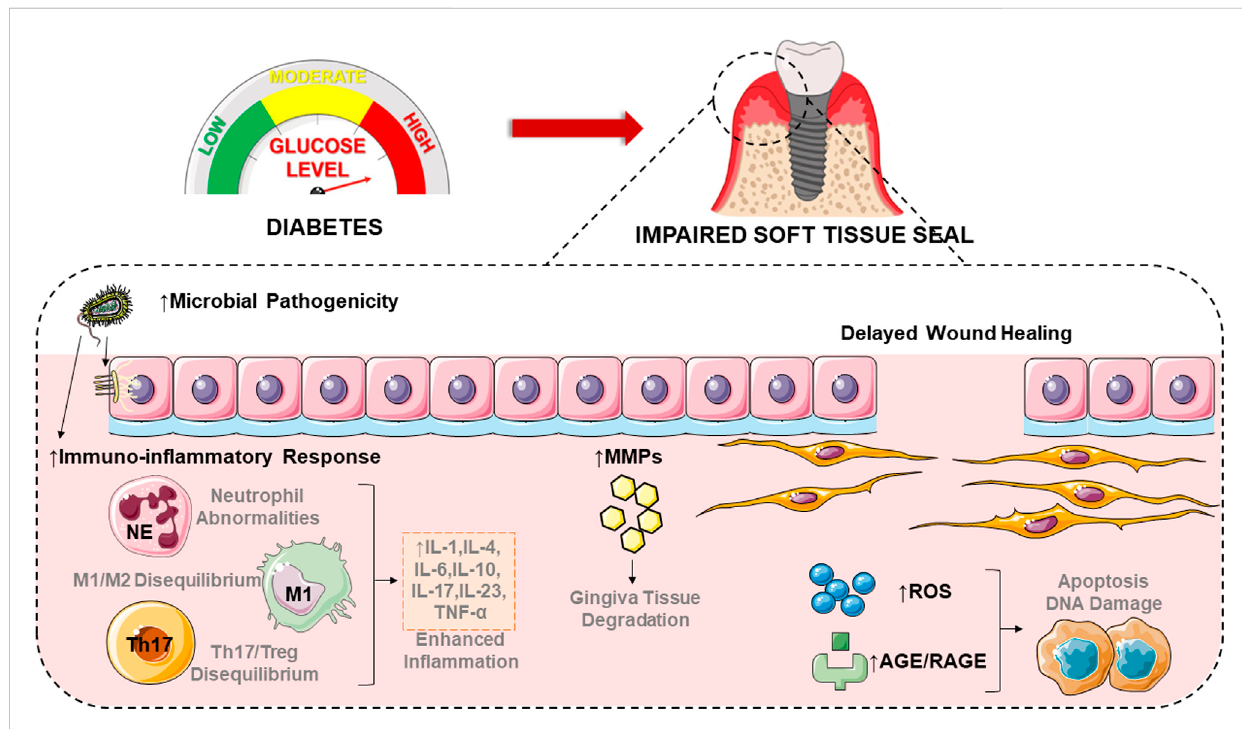
FIGURE 2 Diabetes affects the soft tissues around implants through a variety of mechanisms, including altering bacterial colony composition, promoting in fl ammatory responses, elevating matrix metalloproteinase concentrations, delaying the rate of wound healing, and increasing oxidative stress. The fi gure was partly generated using Servier Medical Art, provided by Servier, licensed under a Creative Commons Attribution 3.0 unported license. IL-1, interleukin-1;IL-4,interleukin-4;IL-6,interleukin-6;IL-10,interleukin-10;IL-17,interleukin-17;IL-23,interleukin-23;TNF- α ,tumornecrosisfactor- α ; MMPs, matrix metalloproteinases; ROS, reactive oxygen species; AGE, advanced glycosylation end-product; RAGE, advanced glycosylation end